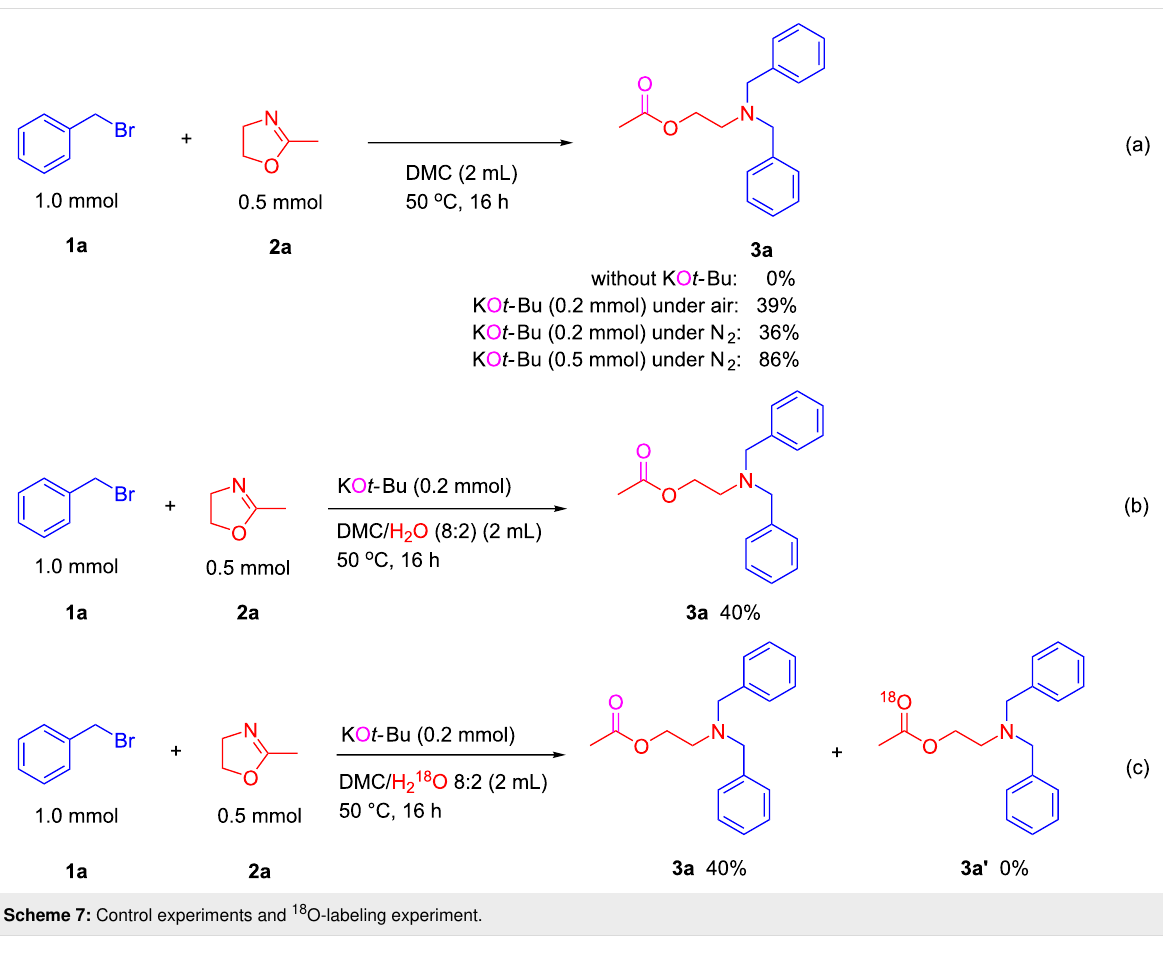
Scheme 7: Control experiments and 18 O-labeling experiment.